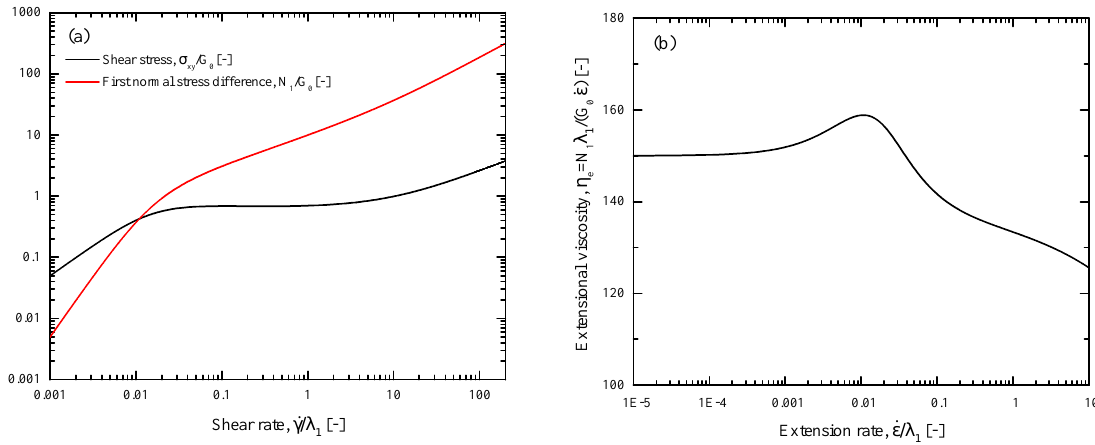
Figure 3. ( a ) Dimensionless shear stress and first normal stress difference vs dimensionless shear rate in homogeneous simple shear flow. ( b ) Dimensionless viscosity vs dimensionless extension rate in homogeneous uniaxial extension.